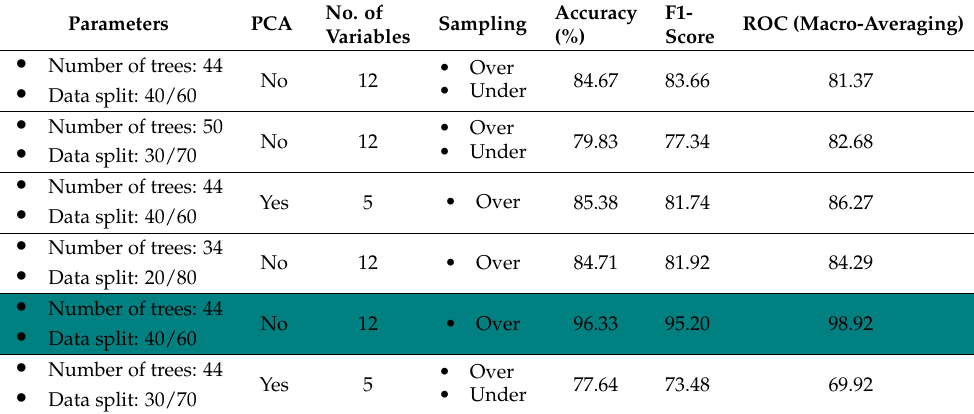
Table 6. The performance of Random Forest